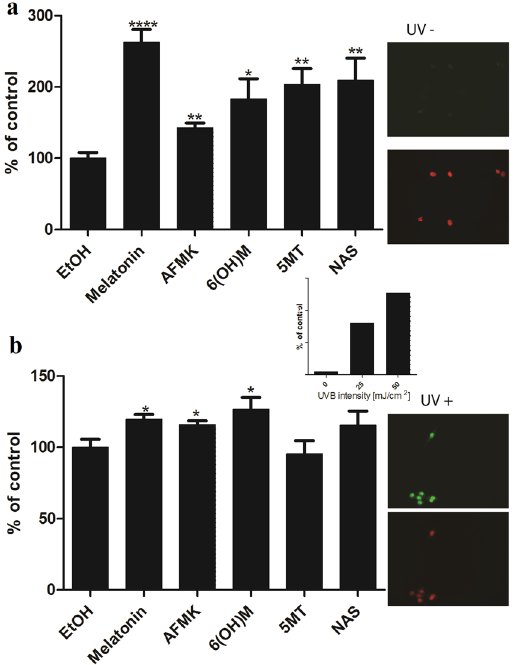
Figure 3. UVB irradiation intensifies p53 levels. Melatonin, NAS, 6-OHM, AFMK, and 5-MT treated HEMn elevated levels of p53 phosphorylated at Serine 15 after UVB exposure. Melanocytes were treated with melatonin or its metabolites for 24 h before UVB exposure. Cells were exposed to UVB intensities of 25 ( a ), or 50 mJ/cm 2 ( b ) and immediately treated again with melatonin or its derivatives for 12 h. Cells were further fixed and stained with anti-phosphorylated p53S15 antibody. Stained cells were imaged with a fluorescence microscope; fluorescence intensity was analysed using ImageJ software. P53 levels increased proportional to UVB intensity (insert). Data are analysed using Graph Pad Prizm. Data are presented as percentile of control and were analyzed using t- test, * p < 0.05, ** p < 0.01, *** p <